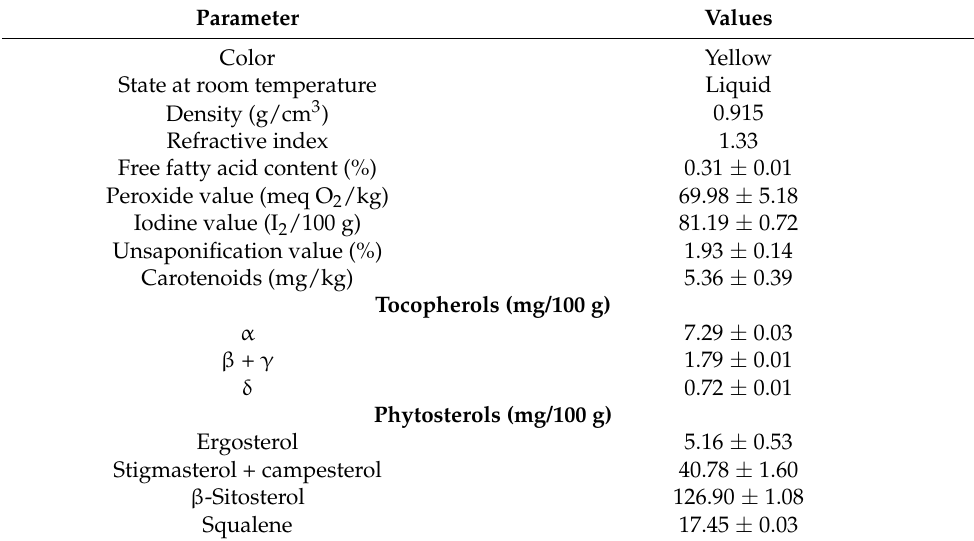
Table 3. Physicochemical characteristics of Balanites roxburghii seed oil.